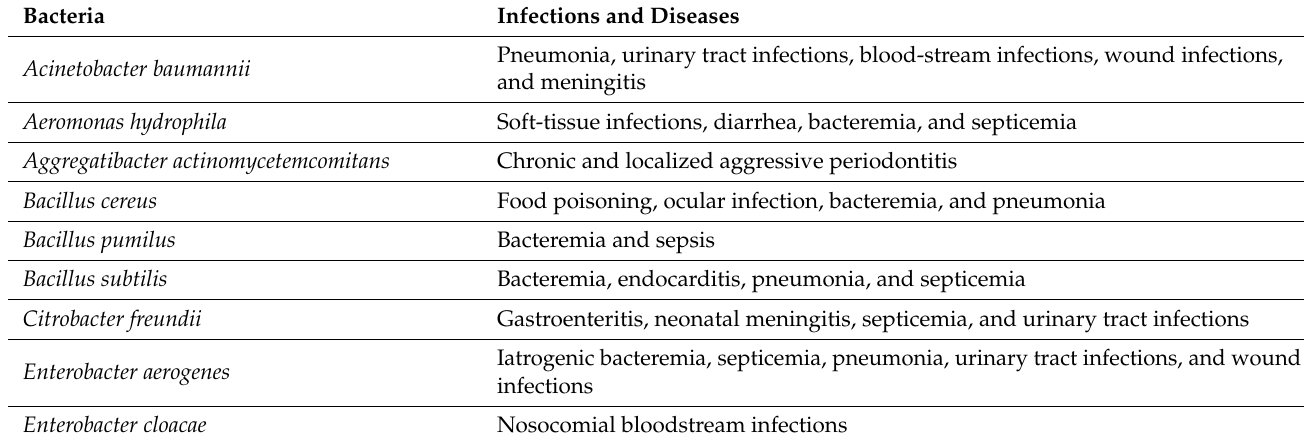
Table A1. A list of bacterial species mentioned in the review and the diseases inflicted by